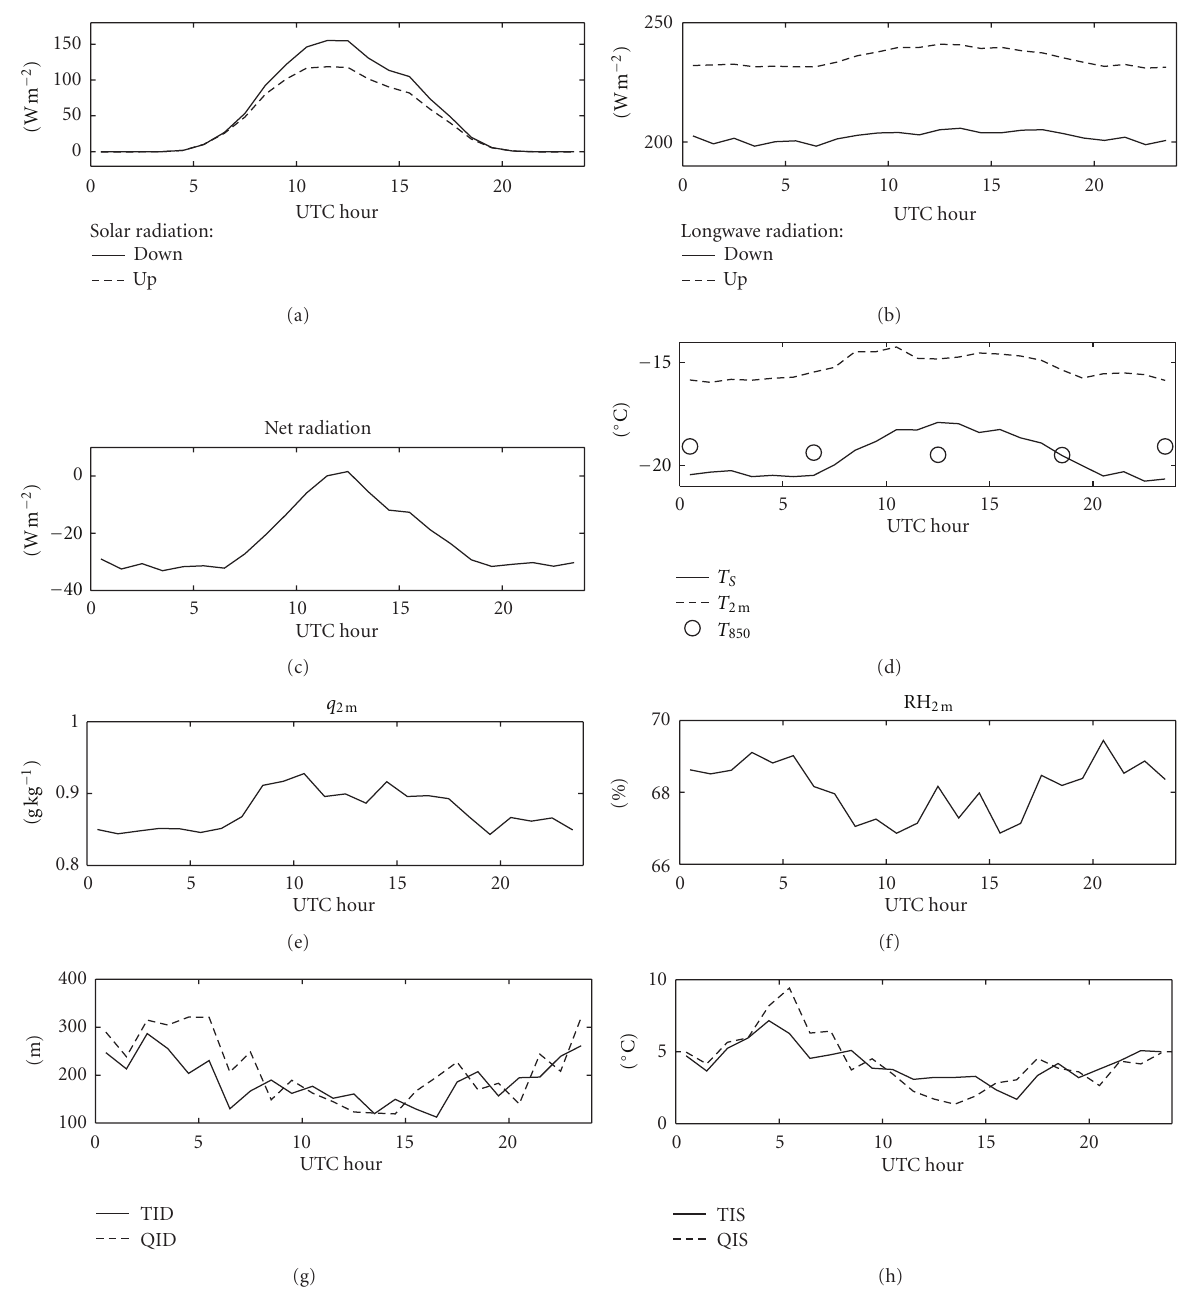
Figure 7: Average diurnal cycles of surface-layer observations and inversion properties, based on AWI soundings at Kongsfjorden.